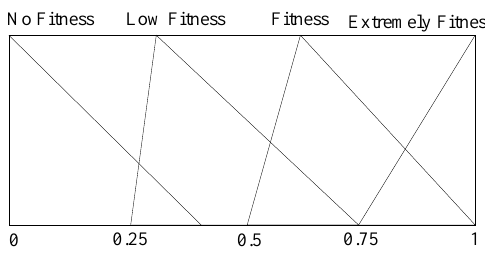
Figure 8. The fuzzy affiliation of node adaptation.